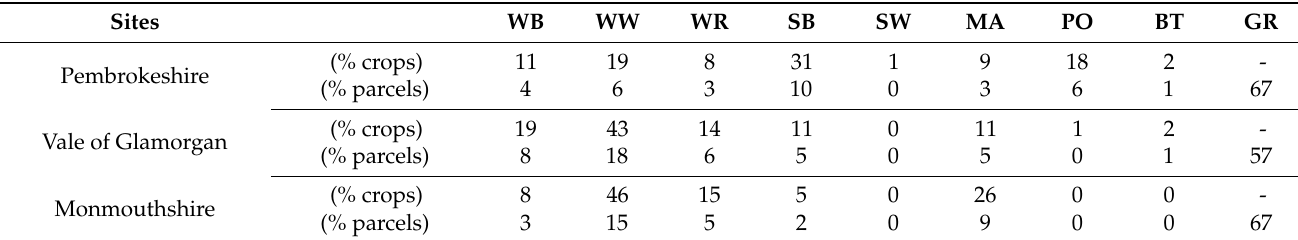
Table 1. Proportion (in%) of each of the main crop types declared by farmers in the three validation areas [source: 2018 Wales Farmers’